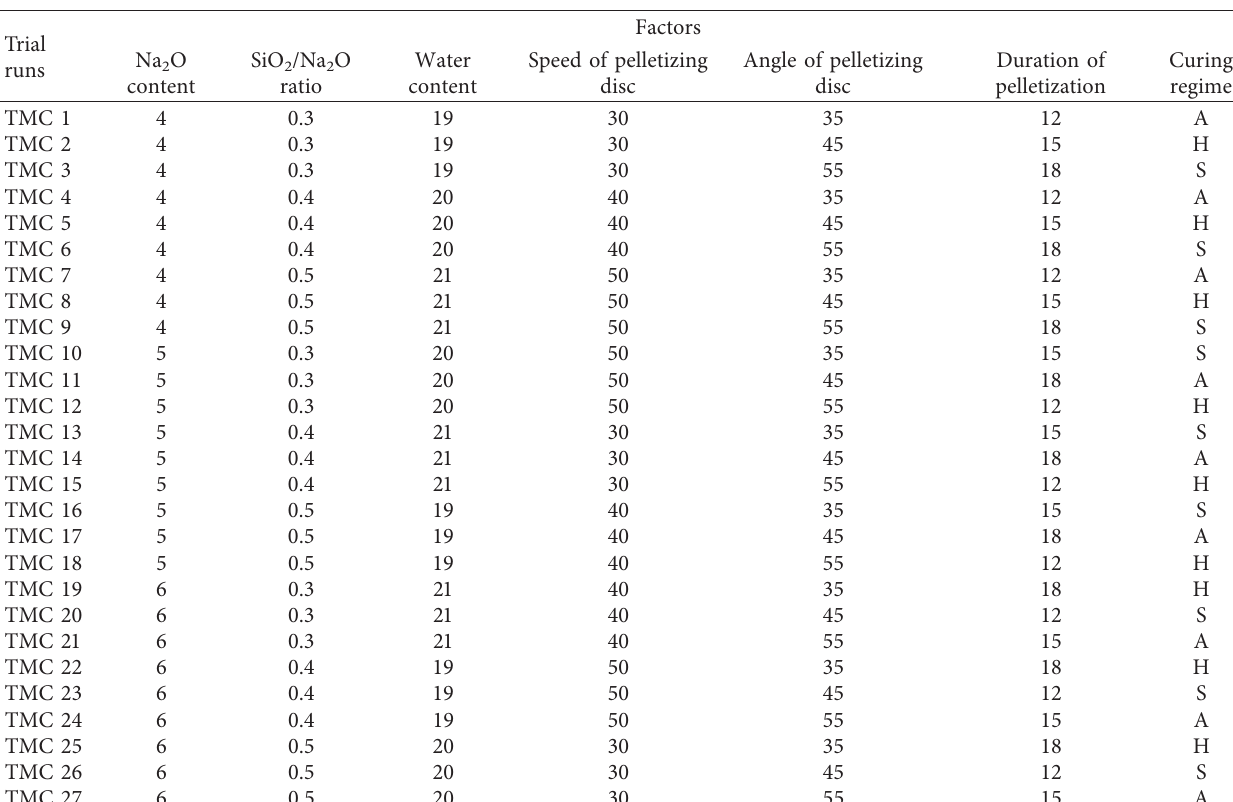
Table 3: Combined factors and values used in the production trial